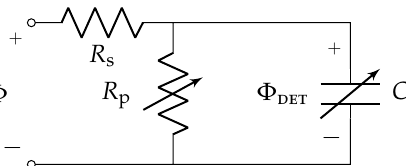
Figure 4. Electrical model of a DET. The electrical behavior of a DET is modeled in this work by a capacitance C that represents the charge storage of the DET that changes as the DET deforms, with a series resistance R s that represents the resistance in the DET’s electrodes, and a parallel resistance R p that represents the current leakage path through the dielectric elastomer. Schematic redrawn and modified from